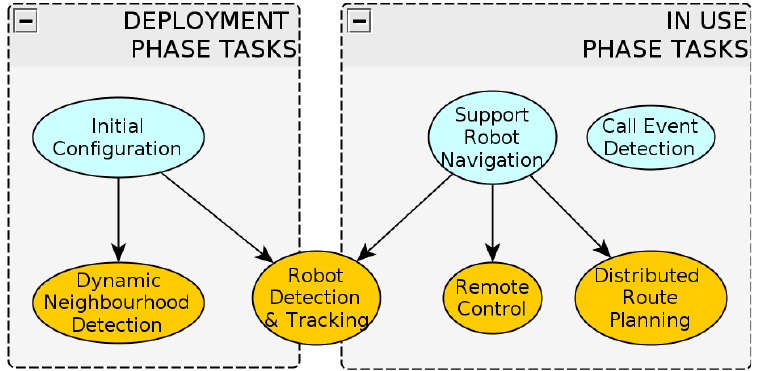
Figure 3. Camera tasks during the deployment and in use